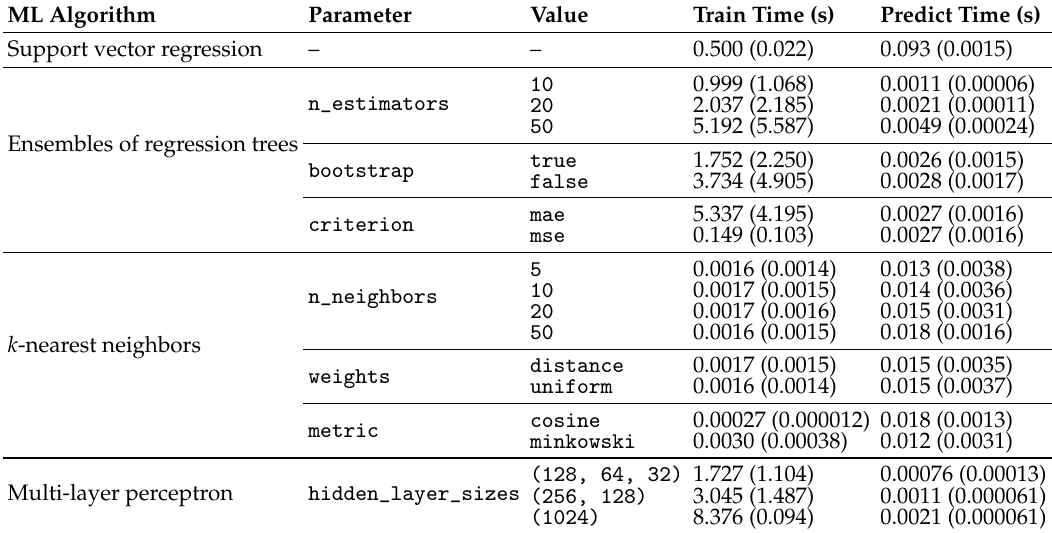
Table 5. Average (and standard deviation) of training and prediction times for different machine learning